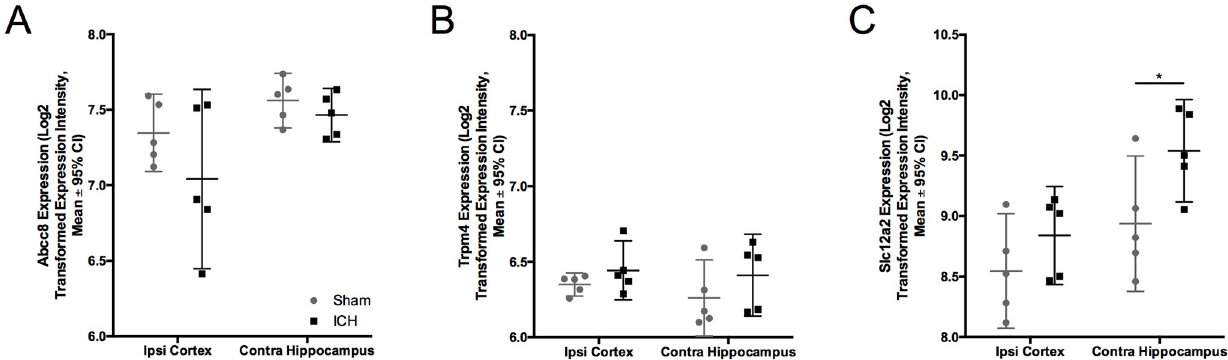
Fig 10. Microarray data. Rats were given ICH and mRNA expression of Abcc8 (A), which codes for Sur1, and Trpm4 (B) was investigated at a 24-hour survival time. ICH did not affect Abcc8 (p = 0.1332) or Trpm4 (p = 0.7338) expression.